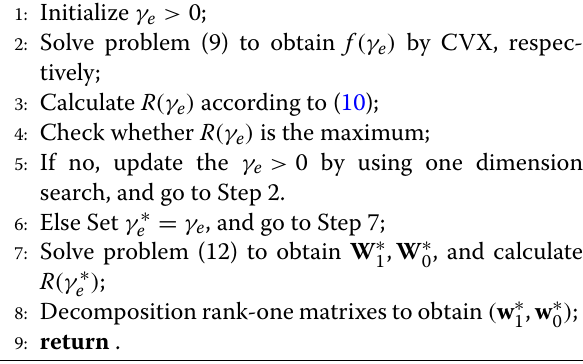
Algorithm 1 The algorithm for optimal solution to